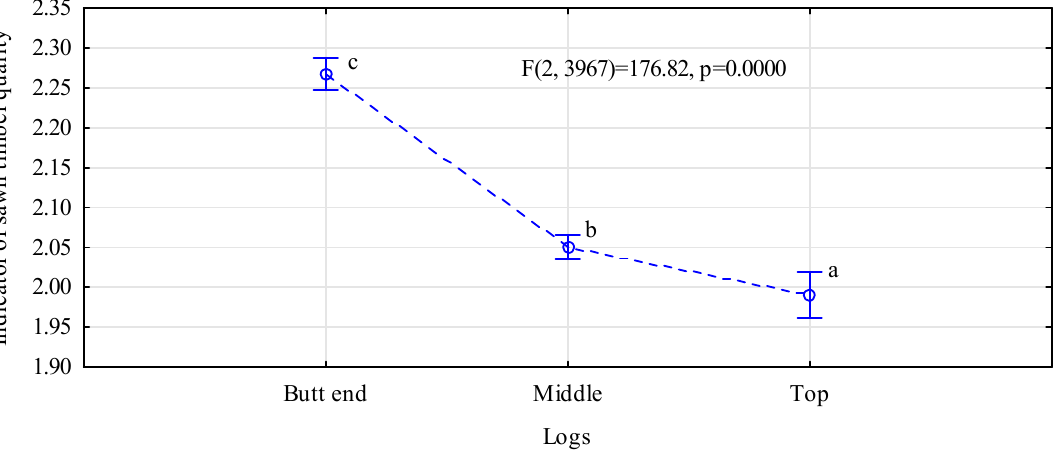
Figure 2. The impact of the origin of logs on the resulting main timber (lower case letters denote homogeneous groups, as determined by the NIR test).